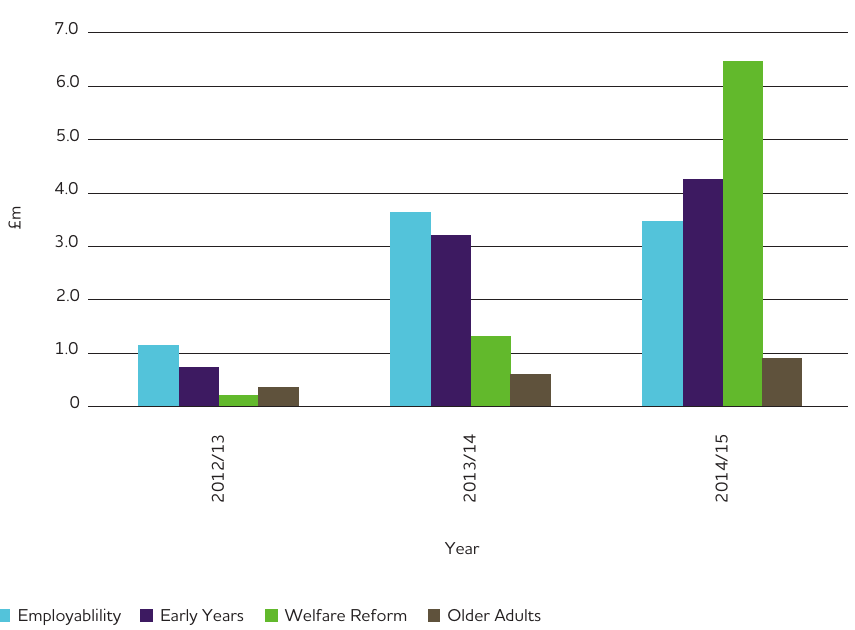
Figure 17: Renfrewshire Investment spend by sphere - 2012/13 to